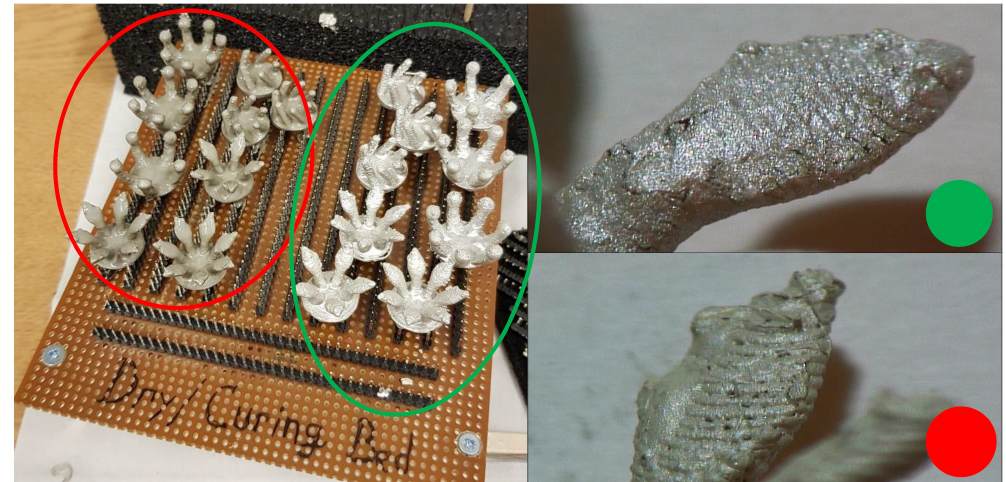
Figure 5. Coated electrodes, with a × 40 zoom. Green: Ag/AgCl used for the results in Section 3. Red: silicone Ag/AgCl, which gave a poor adhesion to the 3D-printed base.